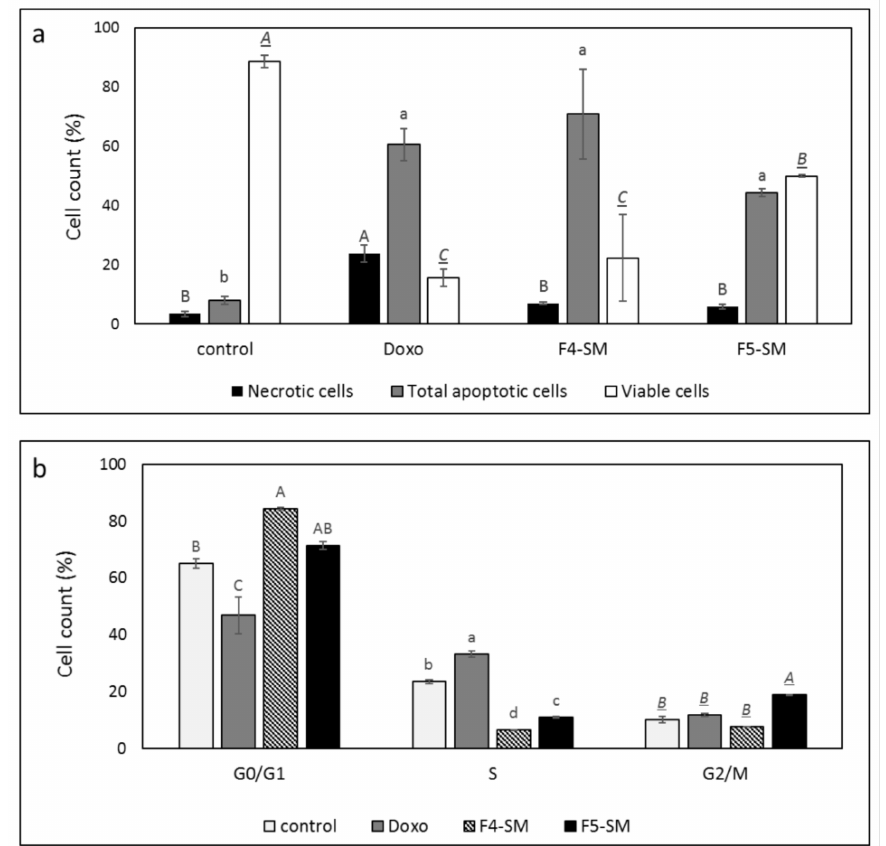
Figure 3. ( a ) Percentage of viability, apoptosis, or necrosis in A172 cells following treatment with F4 SM (10 µ g/mL) or F5 SM (10 µ g/mL) for 48 h. ( b ) Percentage of A172 cells in G0/G1, G2/M, and S phase following treatment with F4-SM (10 µ g/mL) or F5-SM (10 µ g/mL) for 24 h. 10 4